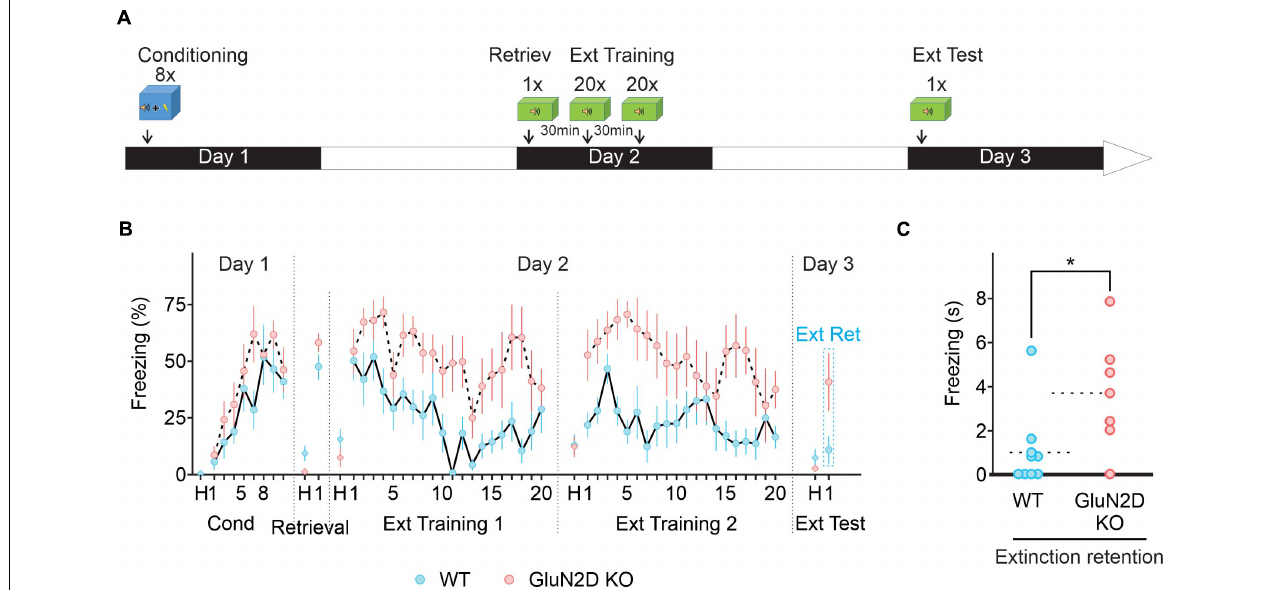
FIGURE 6 | Retrieval-extinction paradigm fails to rescue extinction learning in GluN2D KO mice. (A) Protocol used for retrieval-extinction paradigm. Following fear conditioning, mice were exposed to a retrieval tone in context B on day 2. Thirty min later mice underwent two extinction sessions of 20 tones 30 min apart. On day 3, mice were presented with four tones in context B to test for the retention of extinction memory. (B) Percentage of freezing in wildtype (blue symbols, n = 10) and GluN2D KO mice (red symbols, n = 7). Wild type mice exhibited a clear extinction learning. Extinction learning in GluN2D KO mice was attenuated compared with wild type animals. (C) Individual freezing values at the end of extinction training. Values in the time course are mean ± SEM. * P < 0.05. Statistical analysis values can be found in the Supplementary Table 1